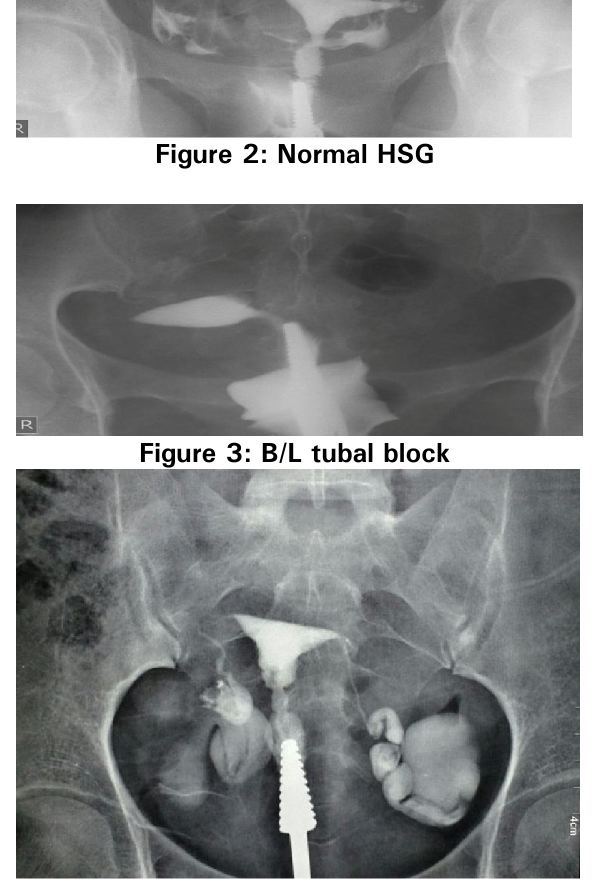
Table 4: Distribution of tubal findings in HSG